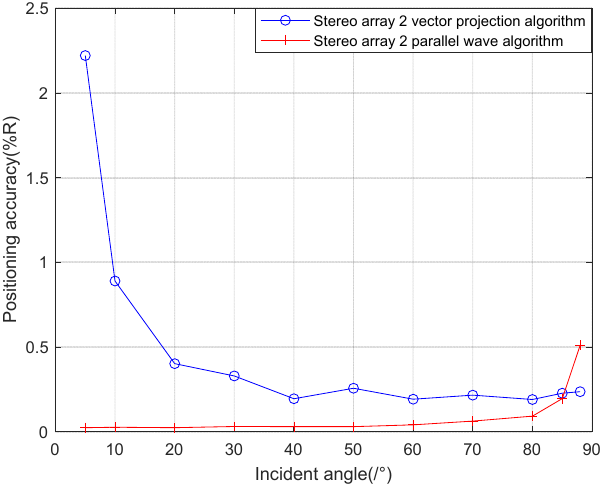
Figure 13. Positioning accuracy of stereo array 2 at different half incident angles.